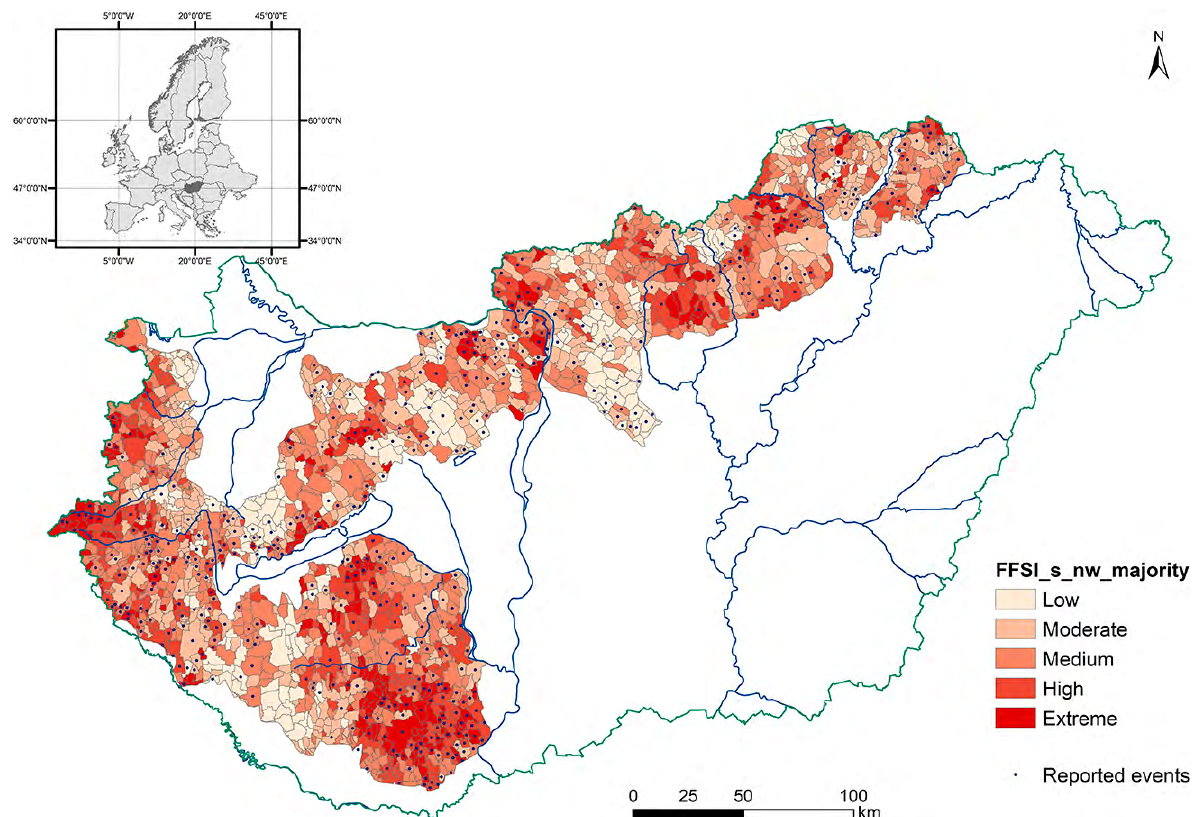
map of Hungary with the majority raster value used for susceptibility Figure 4. FFSI s